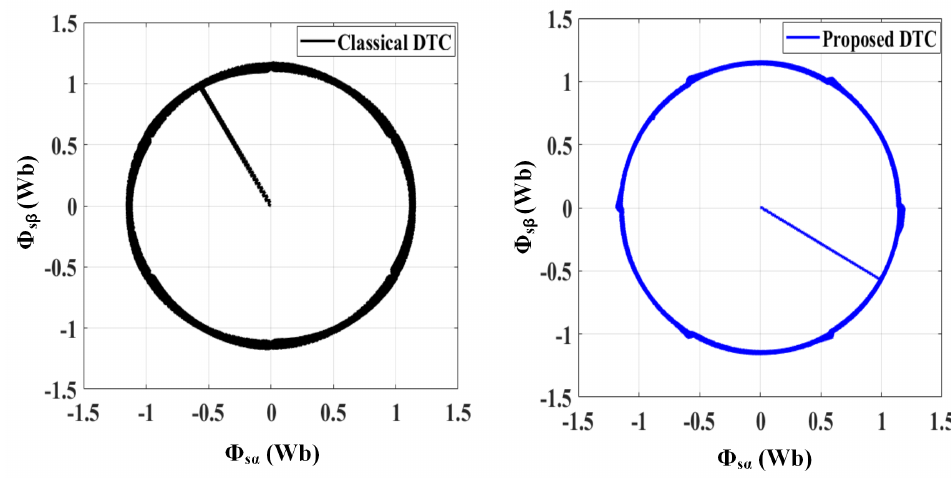
Figure 15. Trajectory of the stator flux vector in both the classical and improved strategy.